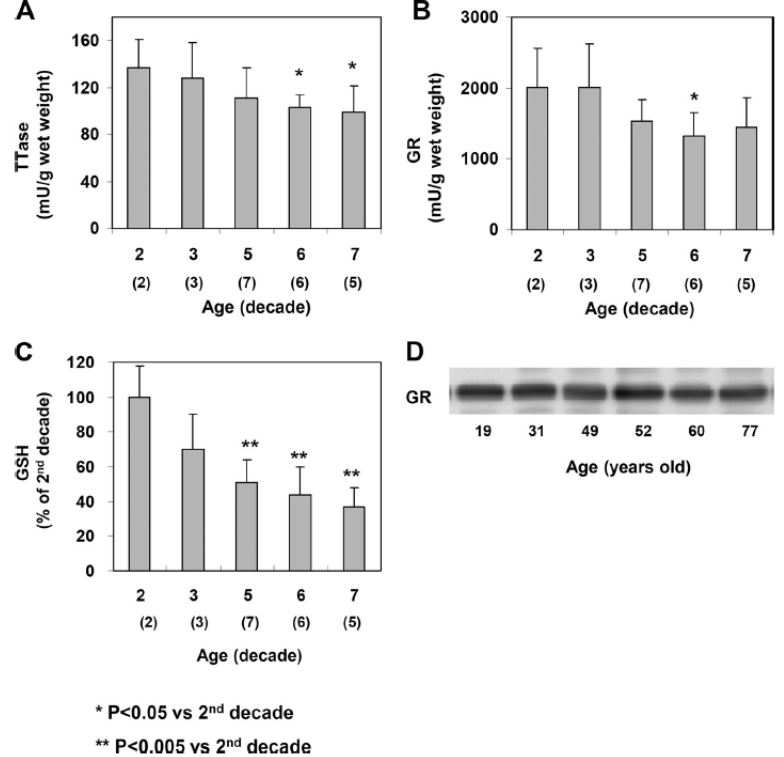
Figure 16. Age-dependent changes of the TTase system in human lenses. Twenty-three normal hu- man lenses, divided into second, third, fifth, sixth, and seventh decades, were used for the study. The data are shown as mean ± SD, with the number of lenses indicated as (n) in each decade. ( A ) TTase activity in mU/g lens wet weight. ( B ) GR activity in mU/g lens wet weight. ( C ) GSH level expressed as percentage of second decade. ( D ) Homogenates from 19-, 31-, 49-, 52-, 60-, and 77-year- old lenses were selected for immunoblot analysis for GR with a specific anti-GR antibody. The blot shown is a representative of three separate analyses. Reprinted with permission from Xing and Lou, IOVS (2010); Copyright ARVO 2010 [112].